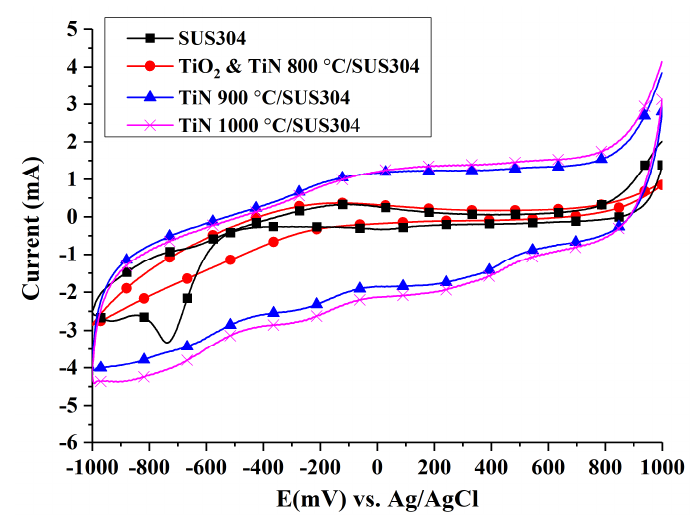
Figure 5. Comparison between cyclic voltammograms of coated and uncoated SUS304 cathodes in the EF system. Note: The solution contains 0.1 M KNO 3 and 20 ppm Fe 2+ , and its pH value was adjusted to pH = 3 using 1 M HNO 3 . Table 4. Corrosion current of the reactive surface area of coated and uncoated SUS304 electrodes in an electro-Fenton (EF) system.